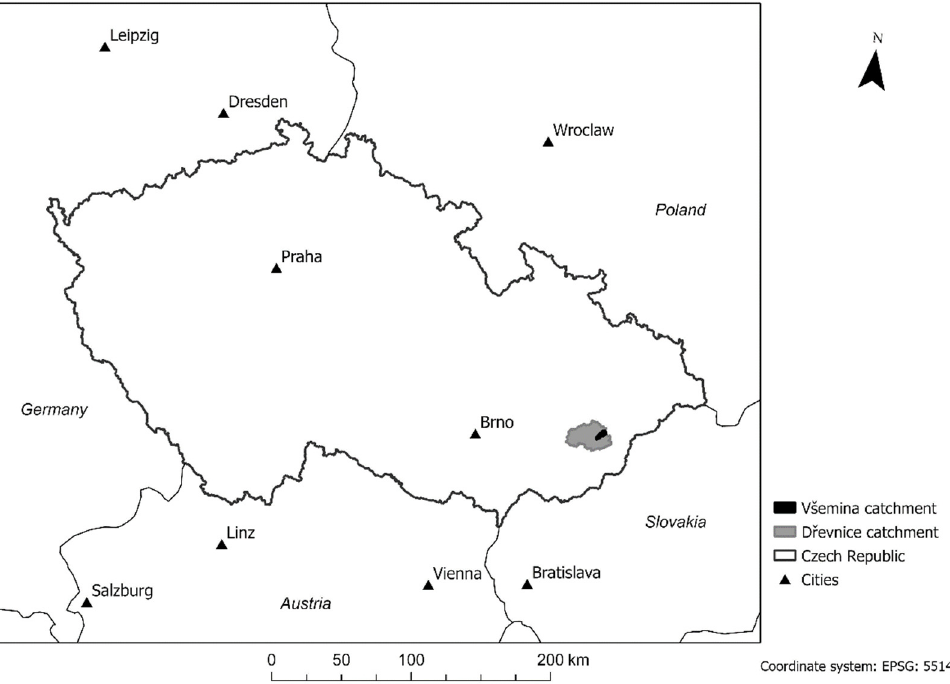
Figure 2. Location of studied areas. All data were used in the national coordinate system EPSG: 5514. In order to preserve the principle of downscaling and the possibility of comparing and controlling values, the studied areas are overlapped.